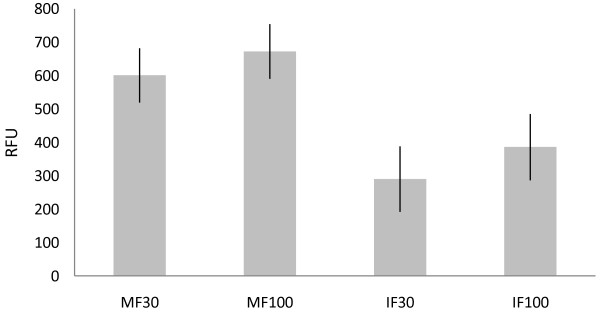
Least squares means of relative fluorescence unit (RFU) values for the nine loci common for both AmpFlSTR® Minifiler™(MF) and AmpFlSTR® Identifiler™(IF) kits. Bars represent 95% confidence intervals in both limits of detection (30 and 100 RFU)